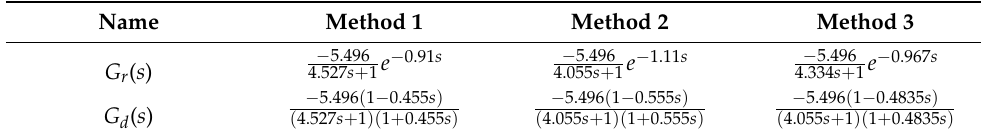
Table 4. Approximated transfer functions by different methods.